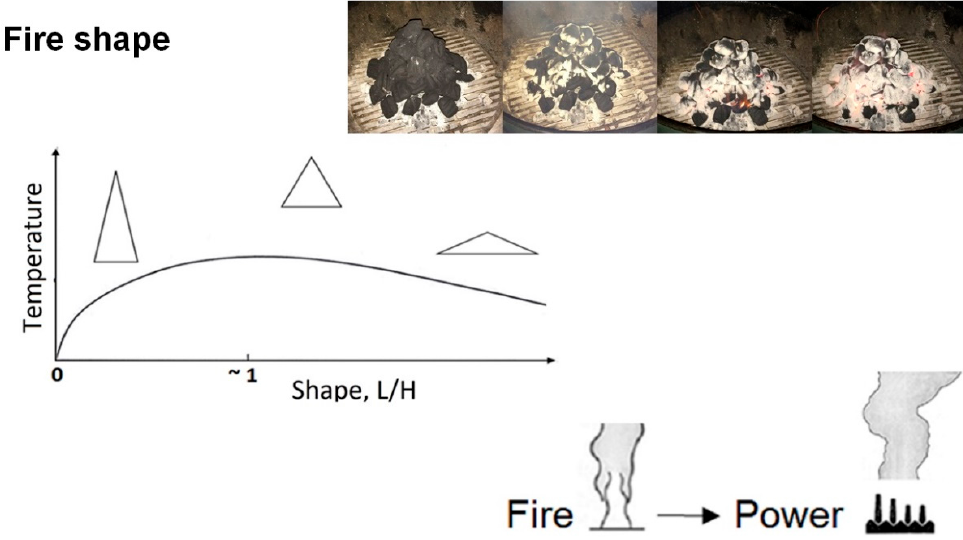
Figure 1. The hottest fire occurs when the shape is as tall as it is wide at the base [17,18]. Chief in the evolution of the homo sapiens was the taming and use of fire 1.5 million years ago), domesticated animals (10,000 years ago) and nature in general (as science,